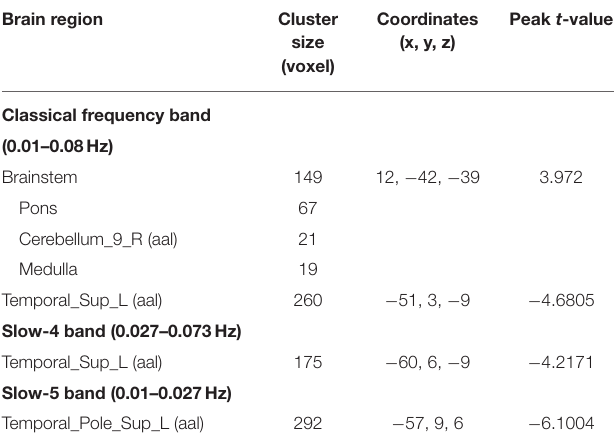
TABLE 1 | Brain regions with alteration of ALFF after cerebellar rTMS.